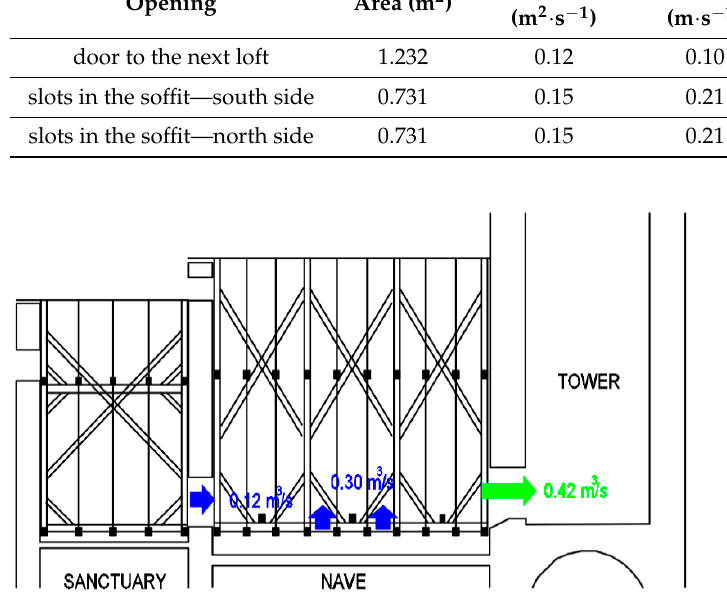
Table 8. Surface temperatures at 2:00 a.m. obtained from BPS simulation.